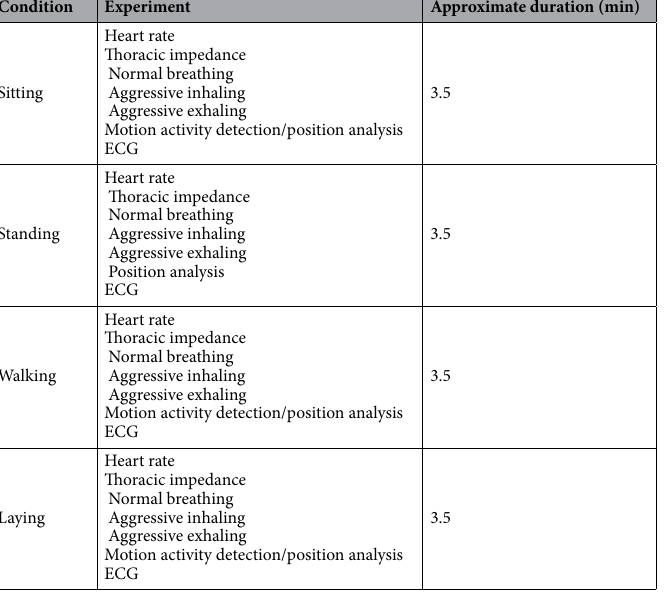
Table 1. The study protocol being followed in each